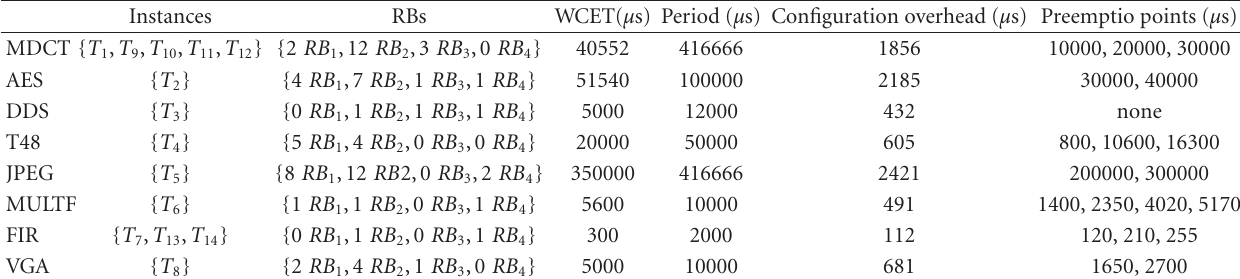
Table 2: Hardware task features.